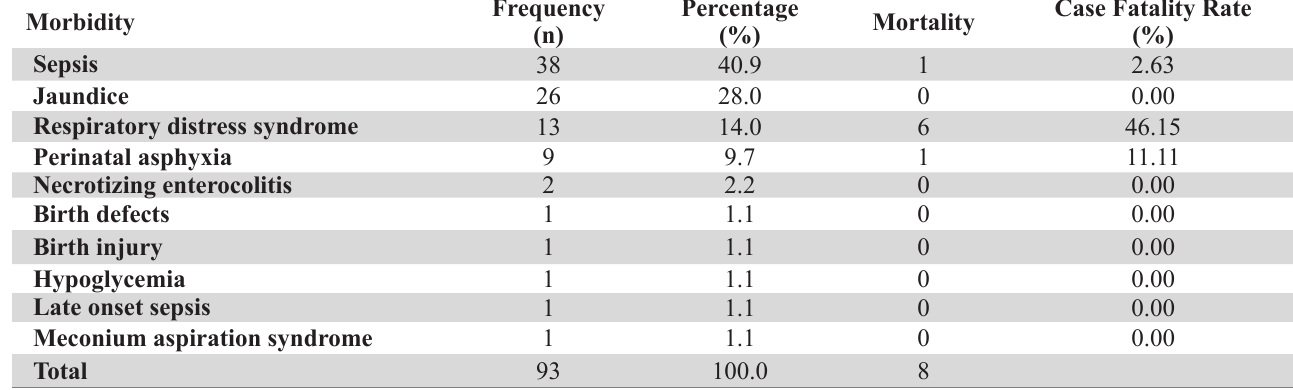
Table 3. Morbidity and Mortality Patterns in Preterm Neonates (n=93)